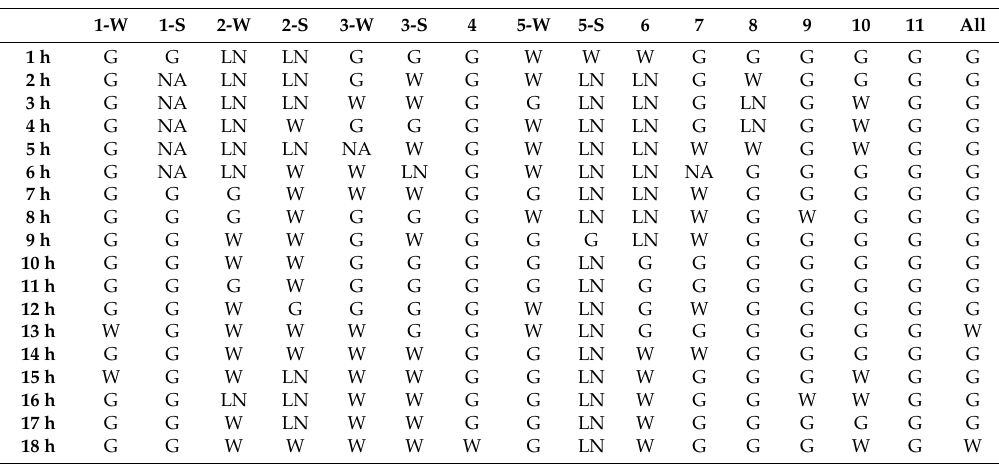
Figure A5. Sample L-points of the individual records of each hour assuming also monthly separation (i.e., 12 × 24 = 288 points for each household) at 15-minute ( a ) and hourly ( b ) scale. Sample L-points of the entire nonzero record of each household (12 points) at 15-minute ( c ) and hourly ( d ) scale. Sample L-points of the records of each hour of the day (24 points) including the data of all households at 15-minute ( e ) and hourly ( f ) scale along with the theoretical lines of the examined distributions. Table A1. Best fitted distributions at the nonzero 15-minute demand records per household and per hour according to ER 1 measure. “W” stands for Weibull distribution, “G” for Gamma distribution, and “LN” Lognormal distribution while “NA” used in the records where it was not possible to fit the models.